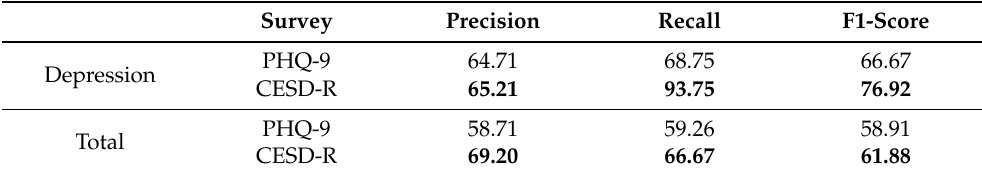
Table 5. Random Forest Classification Result Compared to Diagnosis. The table shows the result of comparing the participant’s diagnosis with depression predictions. The “Depression” row represents the performance predicted to be depressing for 16 depressed patients. When CESD-R is used for depressed patients, the recall rate is 93.75% and the precision rate is 65.21%. Therefore, it shows that CESD-R is more effective than PHQ-9 in predicting depression in patients with